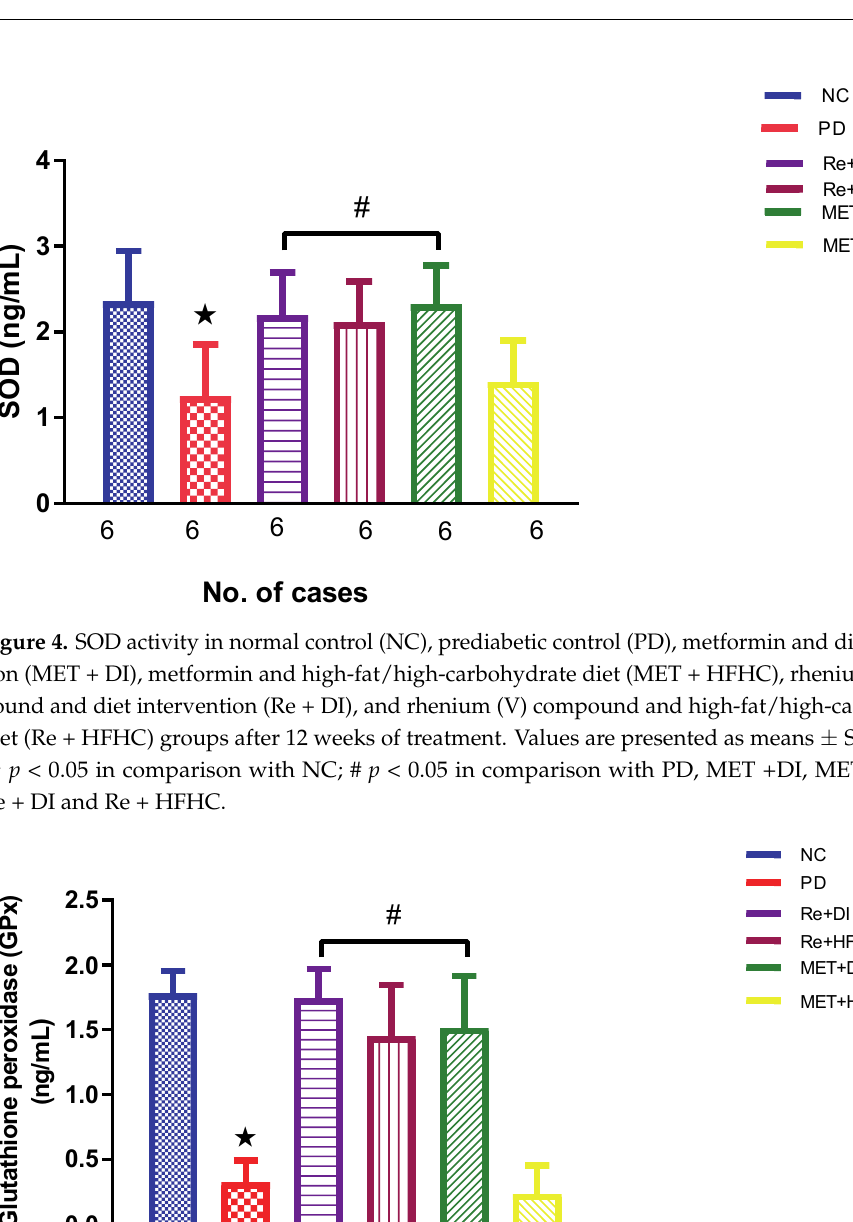
Figure 3. MDA concentration in normal control (NC), prediabetic control (PD), metformin and diet intervention (MET + DI), metformin and high-fat/high-carbohydrate diet (MET + HFHC), rhenium (V) compound and diet intervention (Re + DI), and rhenium (V) compound and high-fat/high-car- bohydrate diet (Re + HFHC) groups after 12 weeks of treatment. Values are presented as means ± SEM (n = 6). p < 0.05 in comparison with NC; # p < 0.05 in comparison with PD, MET +DI, MET + HFHC, Re + DI and Re + HFHC.